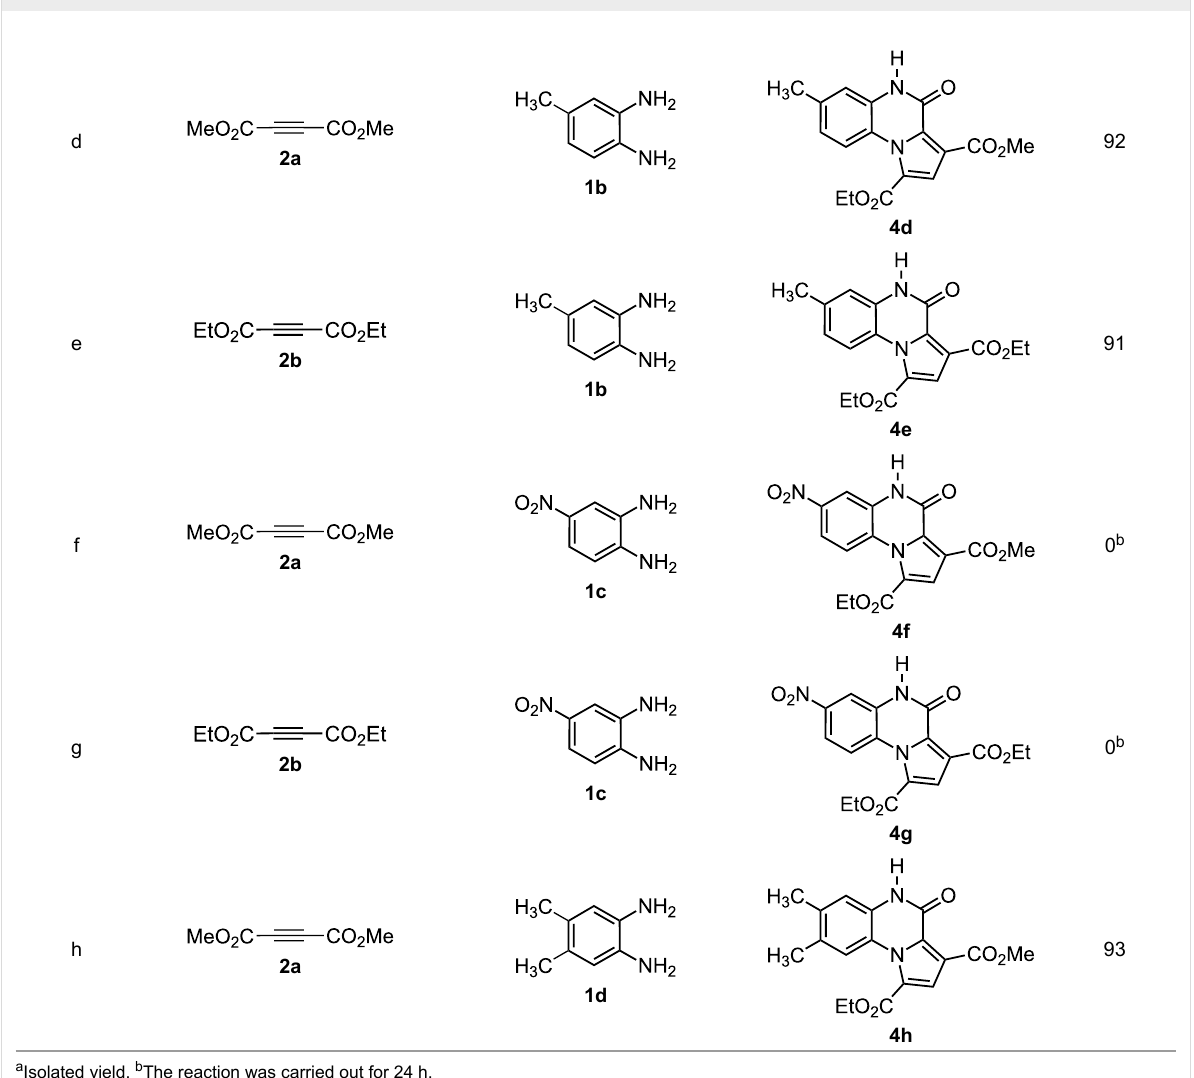
Table 1: Syntheses of pyrrolo[1,2- a ]quinoxalines 4 .